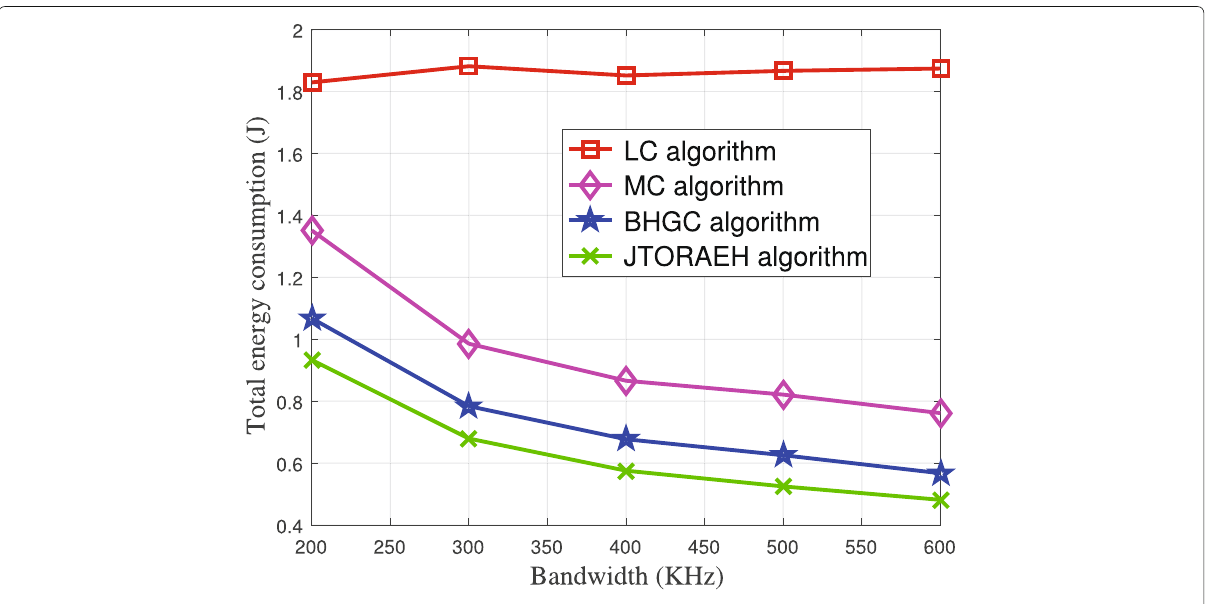
Fig. 4 Total energy consumption versus bandwidth